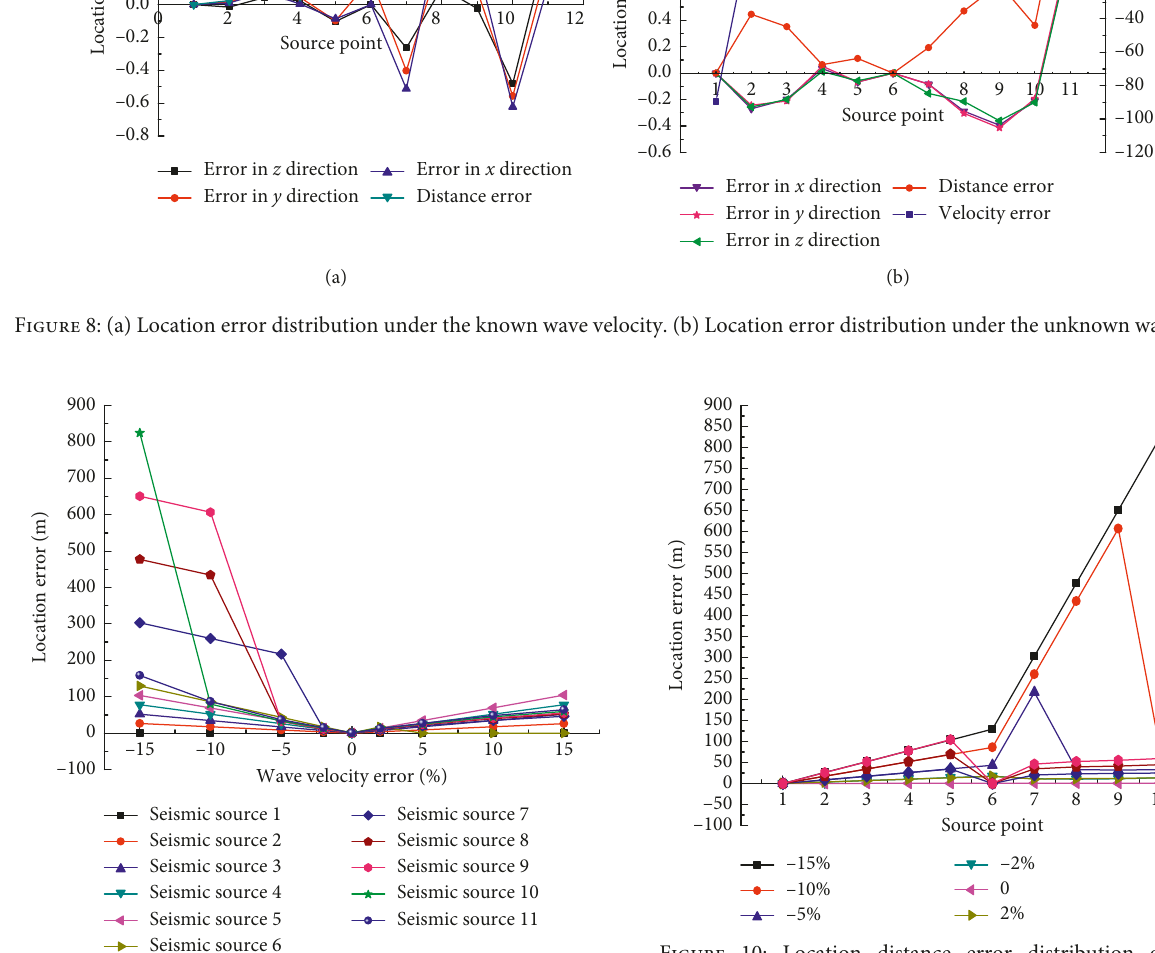
Figure 9: Location distance error distribution of different wave velocity errors.